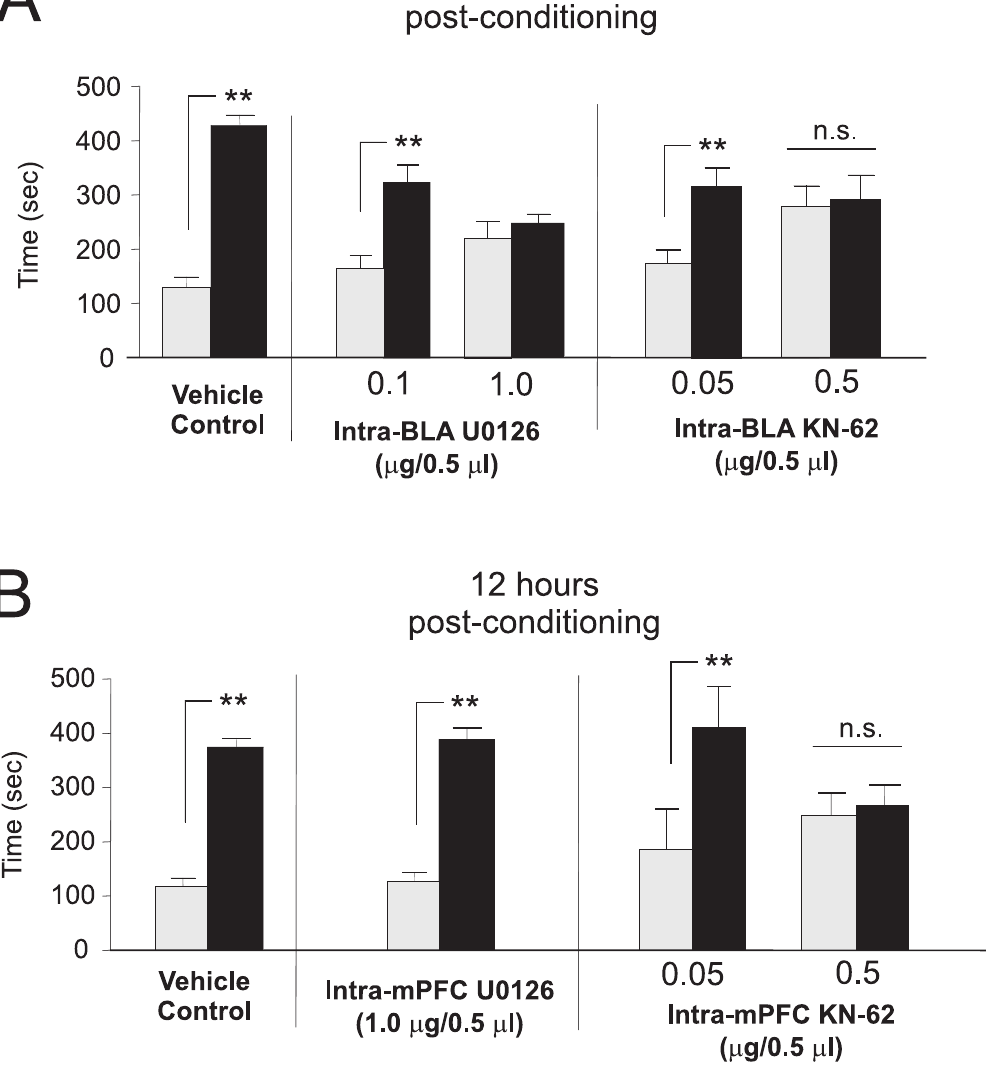
Figure 3. Roles of ERK and CaMKII signalling during recent and remote opiate memory consolidation. A , Relative to vehicle controls, both intra-BLA U0126 (0.1–1.0 m g/0.5 m l) and KN-62 (0.05–0.5 m g/0.5 m l), dose-dependently block opiate reward memory consolidation when administered at the 0 hr time point. B , Relative to vehicle controls, intra-mPFC KN-62, dose-dependently blocked opiate reward memory consolidation when administered at the 12 hr time point, while U0126 has no